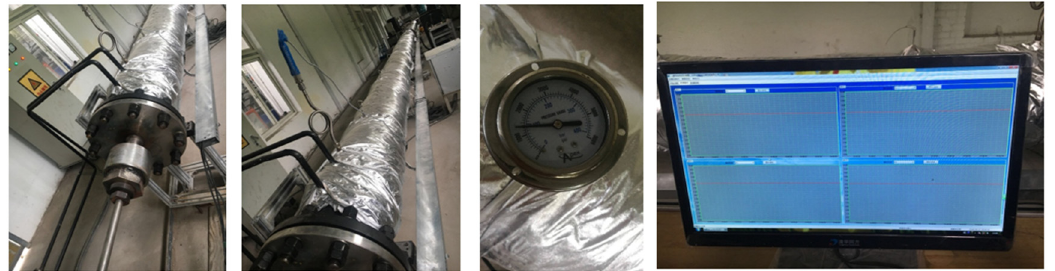
Figure 13. The actual wellbore heating experiment.